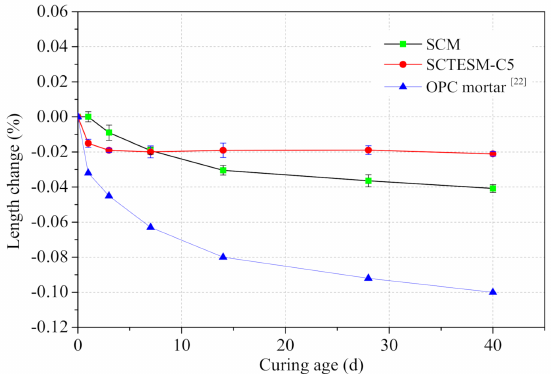
Figure 12. Comparison of volume shrinkage between SCM and SCTESM-C5.